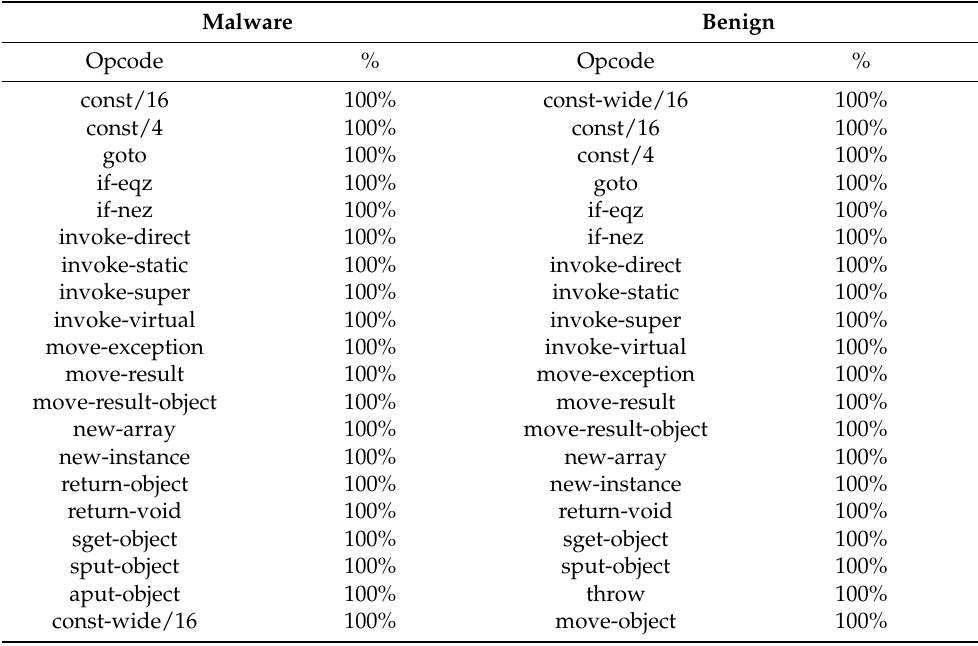
Table 8. Top 20 most common opcodes in malicious and benign